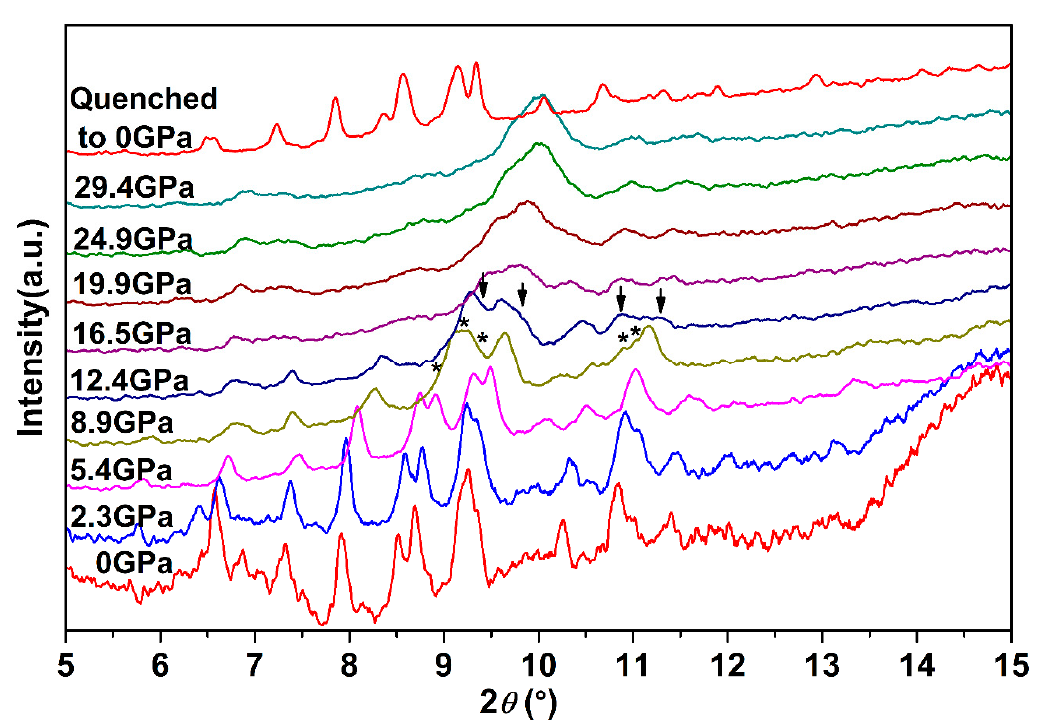
Figure 3. Synchrotron X-ray diffraction patterns of Ag 2 S nanosheets under different pressures. The asterisks and arrows denote the occurrences of new peaks for phase II and phase III, respectively.